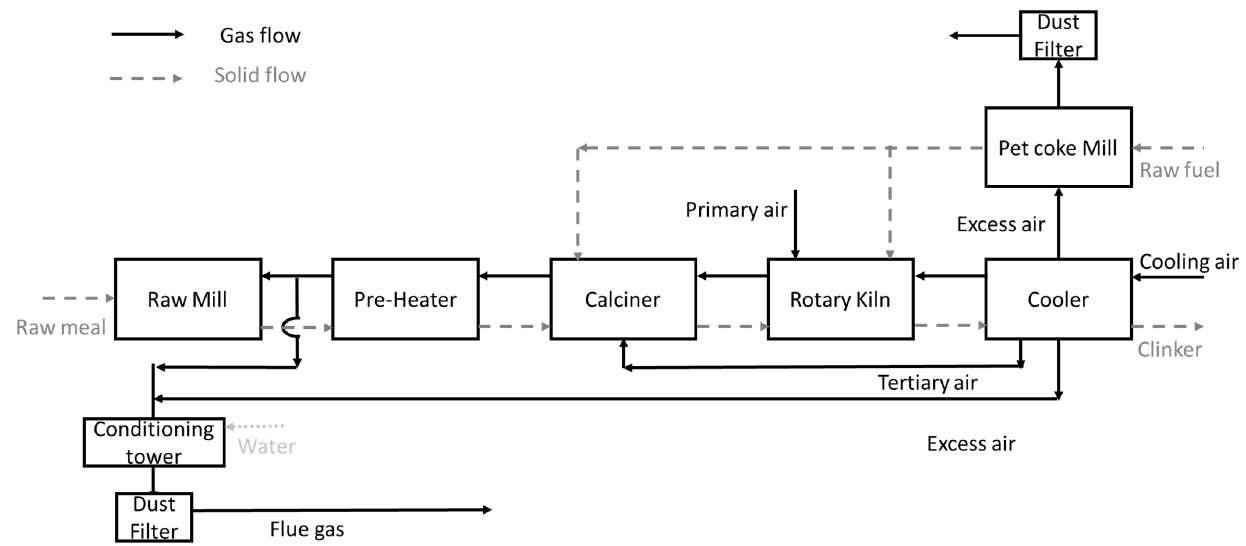
Figure A1. BFD (Block Flow Diagram) of the real clinker production plant in Gubbio, Italy.